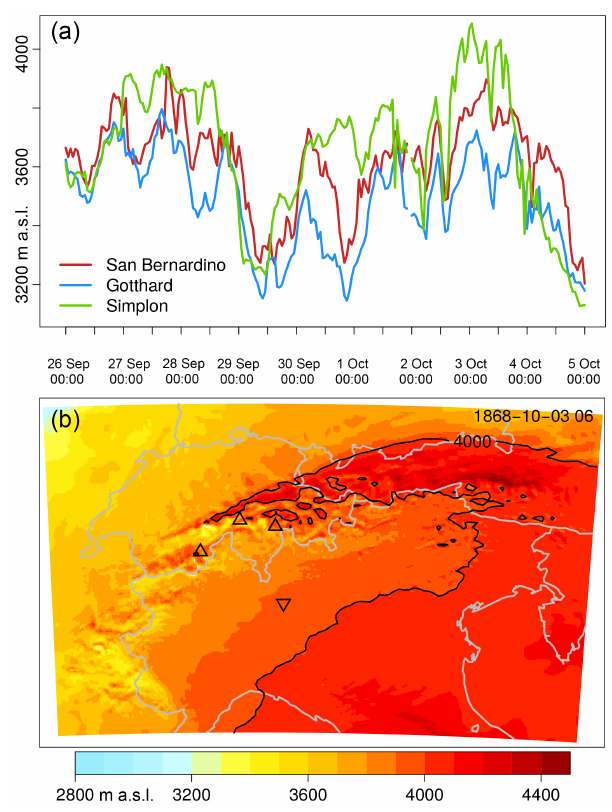
Figure 11. (a) Freezing level at San Bernardino, Gotthard and Sim- plon passes between 26 September 1868, 00:00UTC and 5 Octo- ber 1868, 00:00UTC (x axis; day of the month and hours UTC are given), as calculated for the closest grid point in the WRF simulation. (b) Height of the freezing level (shade and contour at 4000ma.s.l.) for 3 October 1868 06:00UTC. Small white spots in- dicate orography reaching above the freezing level height. Triangles pointing upwards indicate the locations of the San Bernardino, Got- thard and Simplon passes from east to west; the triangle pointing downwards indicates the location of the Milano Linate